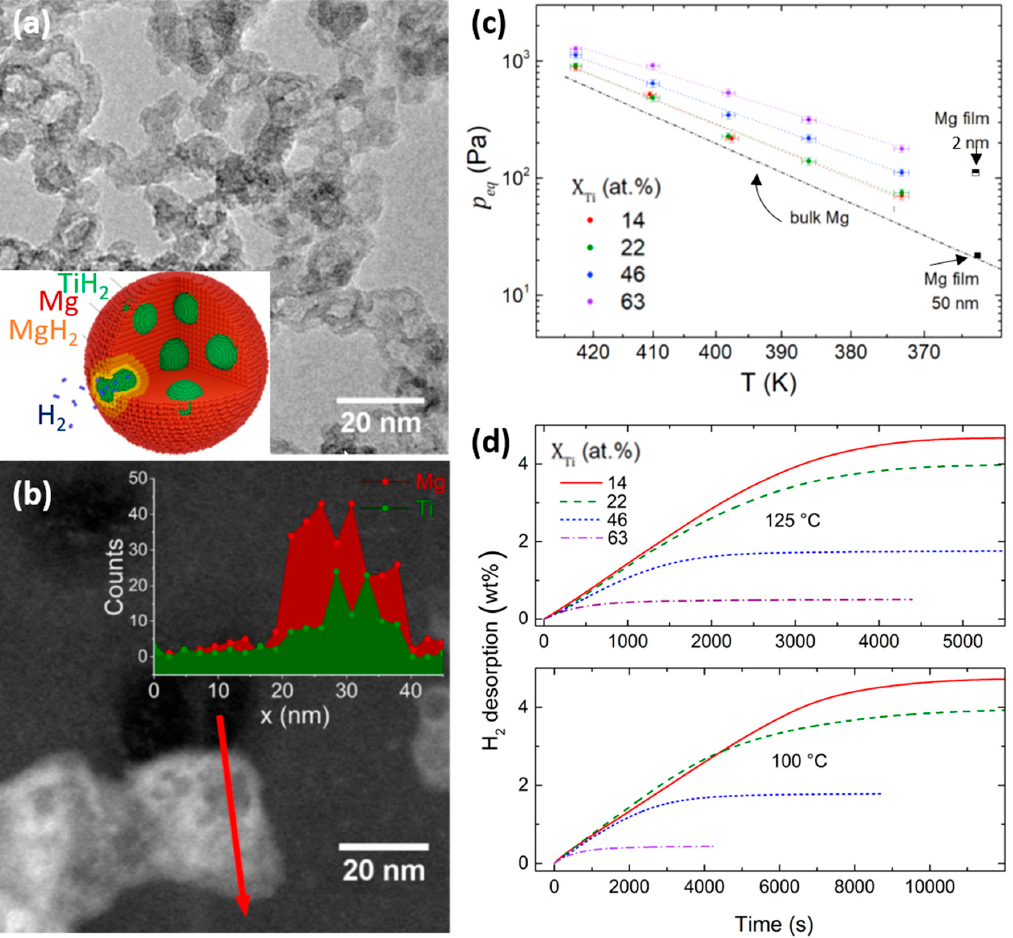
Figure 11. Morphology, composition and H sorption properties of MgH 2 -TiH 2 biphasic NPs prepared by gas phase condensation of mixed Mg and Ti vapors. X Ti represents the Ti / (Mg + Ti) atomic percentage. ( a ) Bright field TEM image of NPs with (cid:1850) (cid:2904)(cid:2919) = 14 ; the inset depicts schematically the two- phase structure and the envisaged hydride formation mechanism. ( b ) High-angle annular dark field scanning TEM of one NP in (a); the inset shows the counts of Mg and Ti K-line x-rays scanned along the red arrow. ( c ) van ‘t Hoff plots for different (cid:1850) (cid:2904)(cid:2919) values; the line expected for bulk Mg and the data measured on Mg films of different thickness are shown for comparison. Reprinted with permissions from [24] (copyright 2020 Elsevier). ( d ) H 2 desorption kinetics from the same NPs at remarkably low temperature (100 and 125 °C). Reprinted with permissions from [33] (copyright 2019 Wiley-VCH). Another interesting example of composite nano-objects is the synthesis of coated Mg NPs as small as 7 nm obtained by first reducing dibutylmagnesium (MgBu 2 ) with Li [105]. Subsequent coating with Co, Fe, Ni, Si, and Ti was obtained via transmetalation; the Mg NPs act as a reducing agent, at the surface of which the precursors are deposited directly. Upon hydriding at high temperature, the coating elements formed complex transition metal hydrides (Mg 2 CoH 5 , Mg 2 FeH 6 , and Mg 2 NiH 4 ) or TiH 2 . The authors highlighted a positive correlation between the desorption time and the reported activation energy for H desorption by the coating material. A modest decrease of the equilibrium plateau pressure compared to naked MgH 2 NPs was also reported, from a 5% for Ti and Si to a 15% reduction for Ni, which the authors correlated with the electronegativity of the coating element [105].